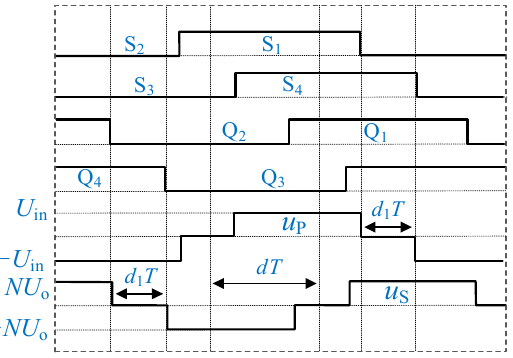
Figure 3. Operation waveforms of DPS modulation method.